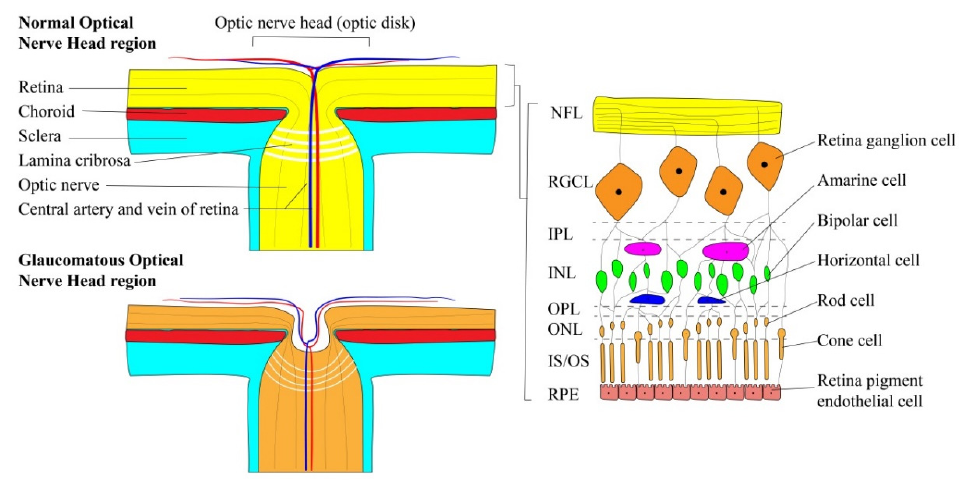
Figure 3. Physiological and pathologic structure of optic nerve head region. NFL: nerve fiber layer, RGCL: retina ganglion cell layer, IPL: inner plexiform layer, INL: inner nuclear layer, OPL: outer plexiform layer, ONL: outer nuclear layer, IS/OS: inner segment/outer segment, RPE: retina pigmented epithelium.